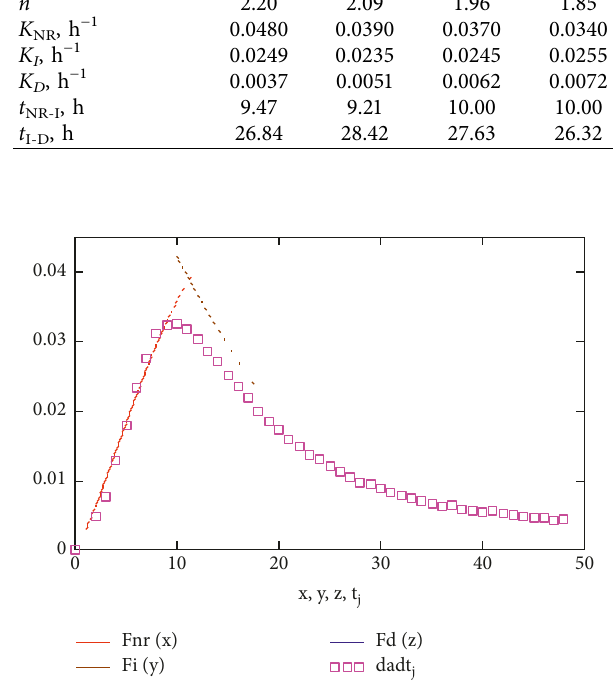
Figure 4: Hydration rate curves of sample C.